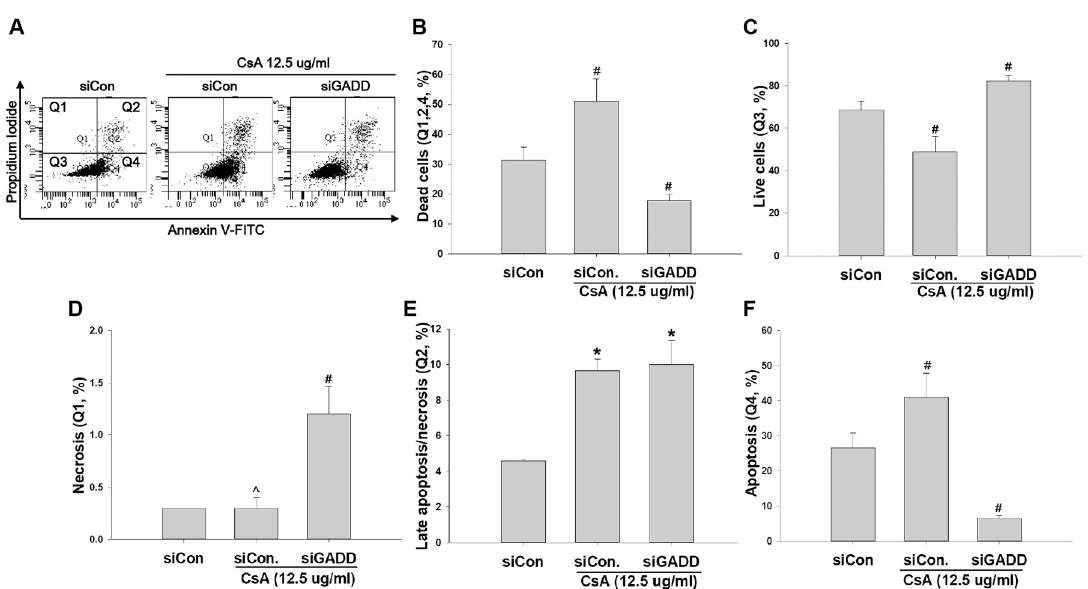
Fig 9. Quantification of cell apoptosis and survival by flow cytometry in CsA-treated HK-2 cells: Effect of GADD45G knockdown. HK-2 cell line was transfected with GADD45G siRNA or control siRNA. At 24 hours after transfection, cells were incubated with 12.5 μ g/ml CsA for 24 another hours. (A) Representative scatter plots of flow cytometry. Quantification of (B) dead cells (Q1+Q2+Q4), (C) viable cells (PI negative and Annexin V negative, Q3), (D) necrotic/non-viable cells (PI positive and Annexin V negative, Q1) (E) late apoptotic/necrotic cells (PI positive and Annexin V positive, Q2), and (F) early apoptotic cells (PI negative and Annexin V positive, Q4). Each bar represents mean ± SD of 3 experiments. Statistical analysis was performed using One-way ANOVA followed by Bonferroni’s post-hoc comparisons tests. A p value < 0.05 was considered significant. � p < 0.05 vs. siCon; ^p < 0.05 vs. siGADD/CsA; #p < 0.05 vs. all other groups. siGADD stands for siRNA targeting GADD45G; siCon, control siRNA targeting no known genes. https://doi.org/10.1371/journal.pone.0260135.g009 PLOS ONE | https://doi.org/10.1371/journal.pone.0260135 November17,